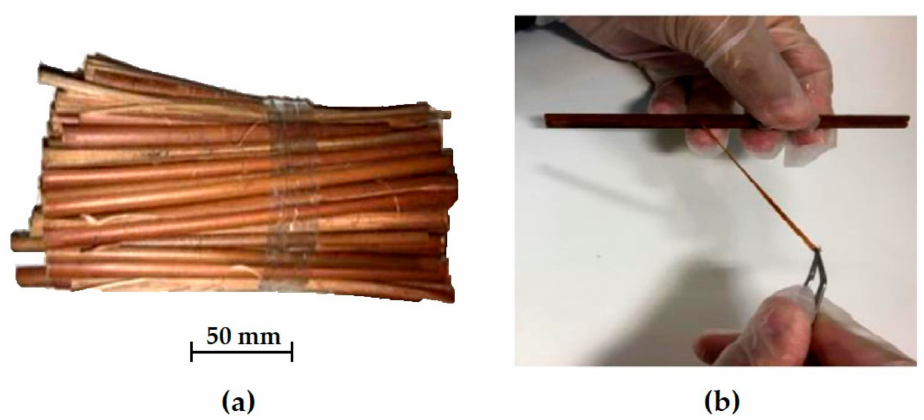
Figure 3. ( a ) As-purchased guaruman splints, and ( b ) manual separation of fiber from the splint (adapted from Reis et al.